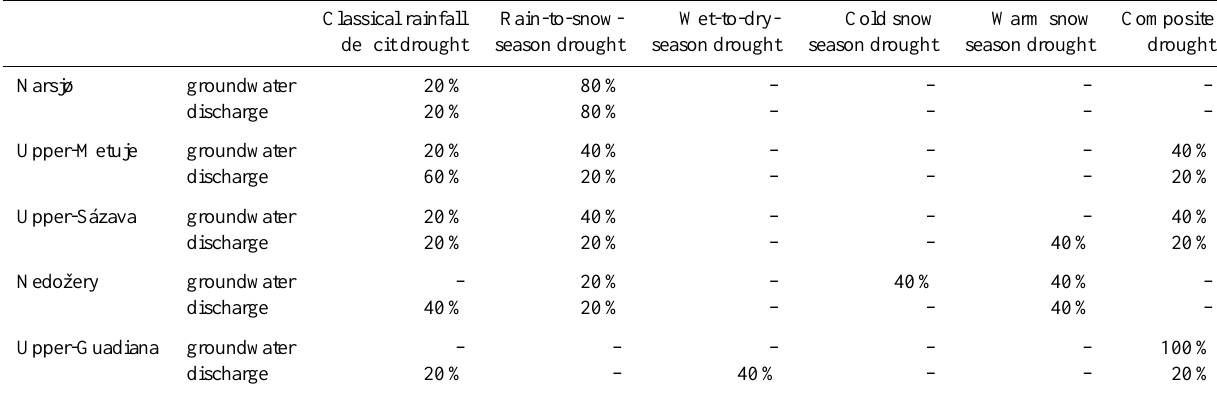
Table 5. Drought types of 5 most severe drought events per catchment (groundwater and